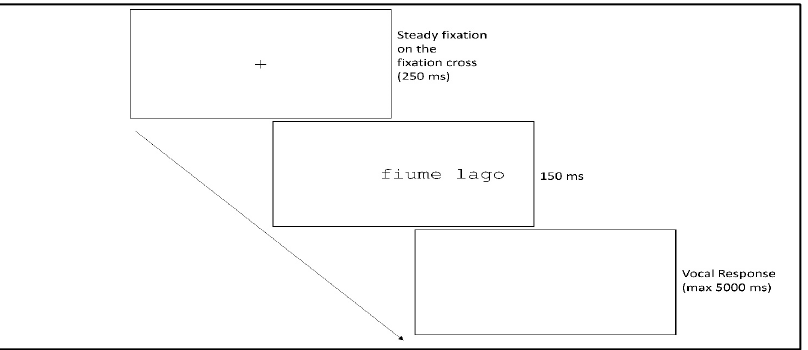
Figure 1. Schematic representation of the rapid parallel visual presentation (RPVP)